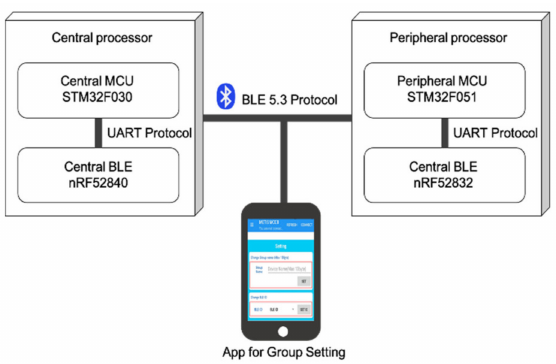
Figure 3. Conceptual diagram of multilink IoT sensor